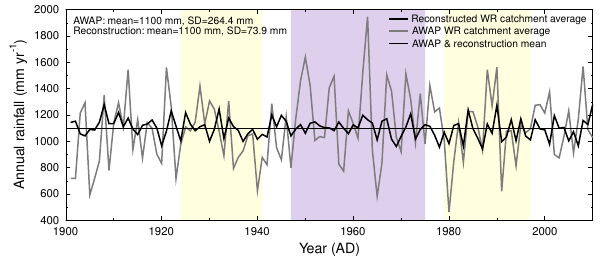
Figure 4. Reconstructed rainfall (thick black), AWAP WR catch- ment average rainfall (grey) and reconstruction/AWAP mean rain- fall (thin black). Shading indicates IPO positive (yellow) and IPO negative (purple)